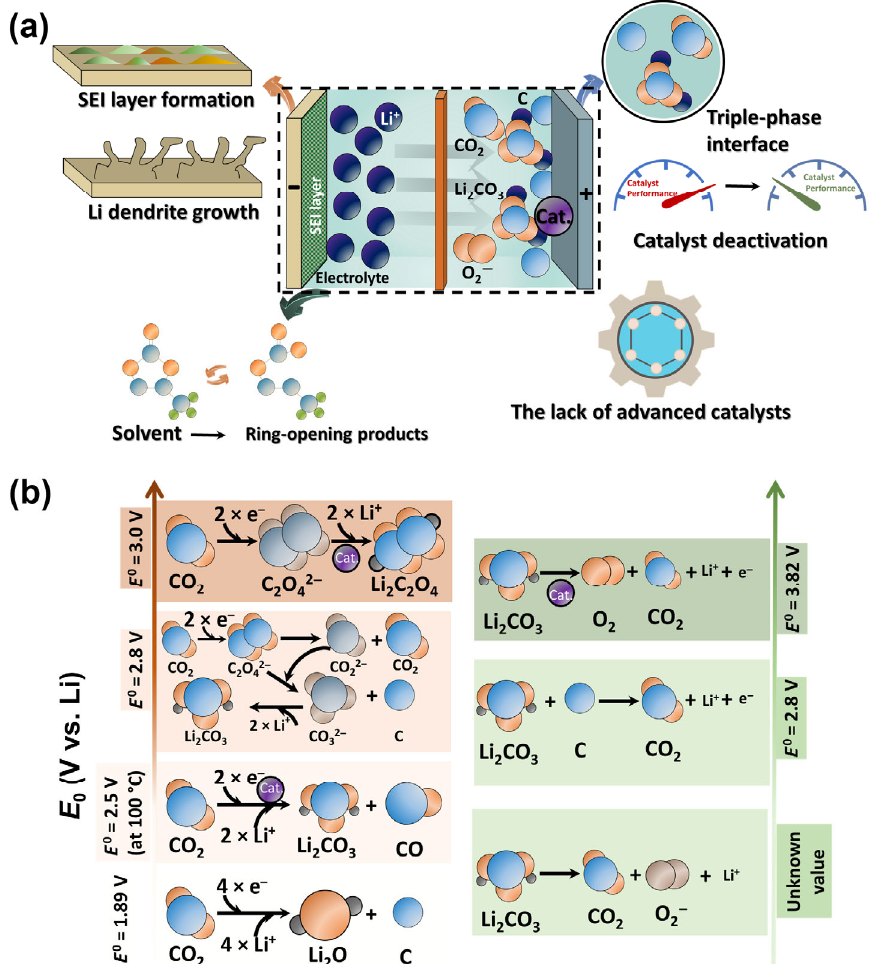
Figure 2 (a) Critical challenges associated with the current Li–CO 2 batteries. The challenges can be mainly classified as anode issues, electrolyte issues, interfacial issues, and cathode issues. The cat. represents catalysts. (b) Possible discharge or charge reactions in Li–CO 2 batteries and the reversible potentials of corresponding